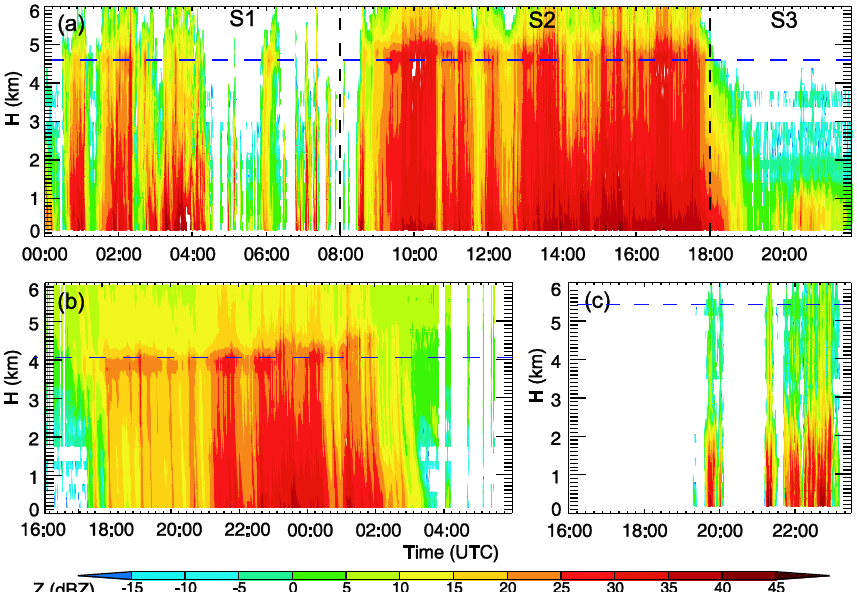
Figure 3. The vertical profile of radar reflectivity from the MRR for ( a ) one tropical cyclone occurring on 25 August 2005, ( b ) one meiyu-baiu front occurring on 21 June 2005 and ( c ) one local storm occurring on 1 August 2007. The blue dashed lines denote the 0 ◦ C isotherm level measured by the Tateno radiosonde sounding station, while the grey dashed lines in (a) denote the three rain stages of the tropical cyclone.